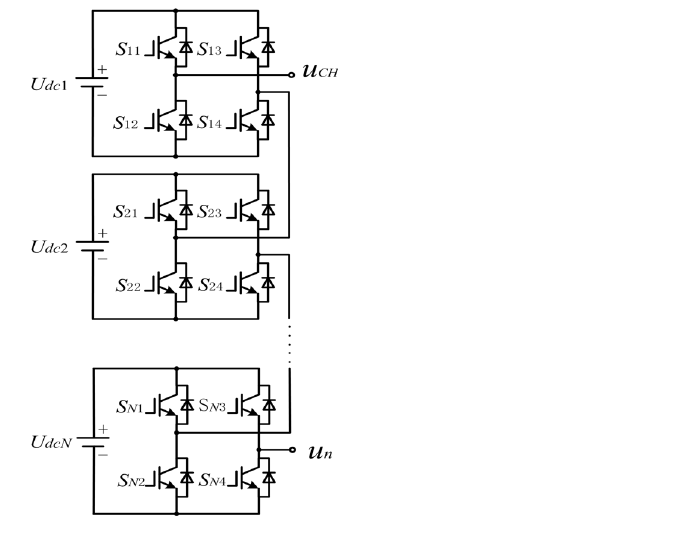
Figure 1. Topology of a single-phase leg of a cascaded H-bridge multilevel (CHBML)